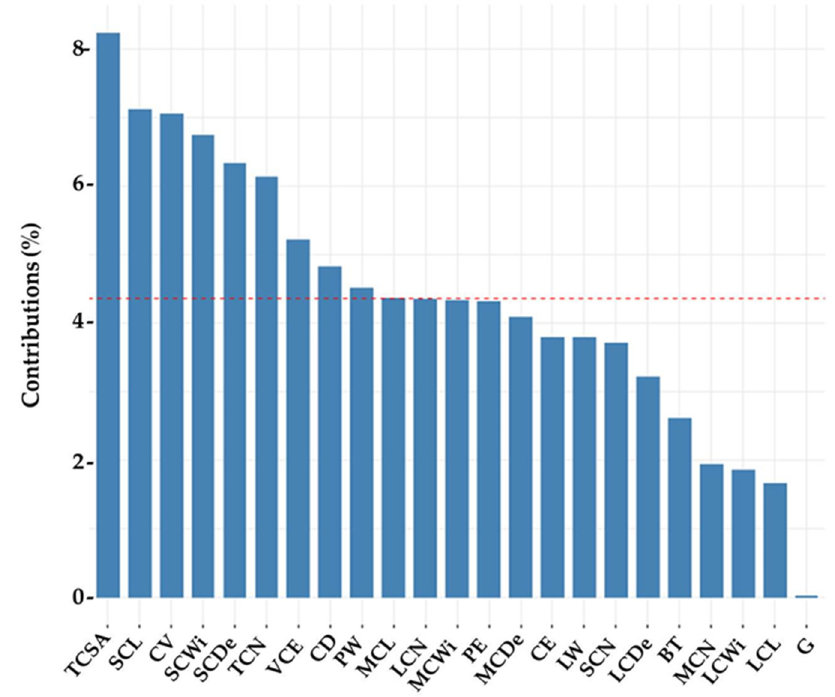
Figure 2. Contribution of variables to components 1 and 2. TCSA = total cotyledon surface area, SCL = small cotyledon length, CV = cotyledon volume, SCWi = small cotyledon width, SCDe = small cotyledon depth, TCN = total cotyledon number, VCE = volumetric cotyledon efficiency, CD= cotyledon density, PW = placental weight, MCL = medium cotyledon length, LCN = large cotyledon number, MCWi = medium cotyledon width, PE = placental efficiency, MCDe = medium cotyledon depth, CE = cotyledon efficiency, LW = litter weight, SCN = small cotyledon number, LCDe = large cotyledon depth, BT = birth type, MCN = medium cotyledon number, LCWi = large cotyledon width, LCL = large cotyledon length, G = gender.